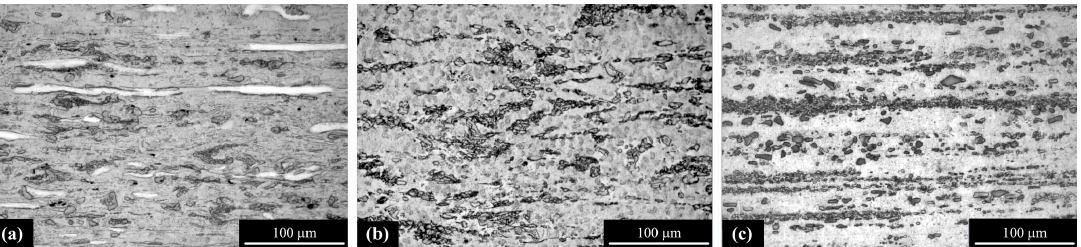
Figure 4. Microstructures of as-extruded (a) Gd-containing, (b) Nd-containing and (c) Ce-containing alloys.